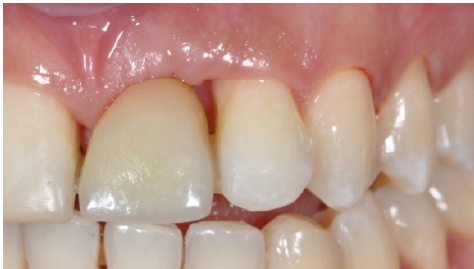
Figure 10. Papilla recession at the mesial area of the left maxillary lateral incisor two weeks after implant placement.